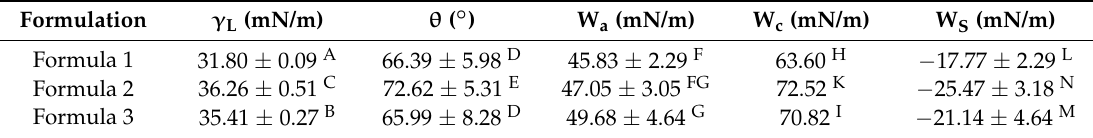
Table 4. Surface tension ( γ L ), contact angle θ ( ◦ ), adhesion coefficient (W a ), cohesion coefficient (W c ), and wettability (W S ) data of formulations. Formula 1: 1.25% sodium alginate + 2% glycerol +